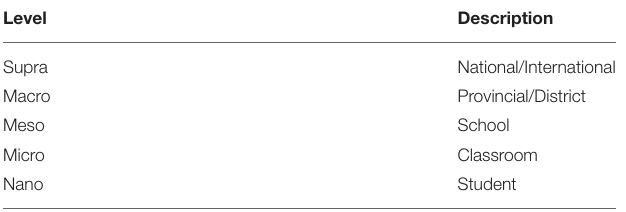
TABLE 2 | van den Akker (2013) curriculum levels, adapted for use. TABLE 3 | Approximate time used to design, enact and reflect in three making